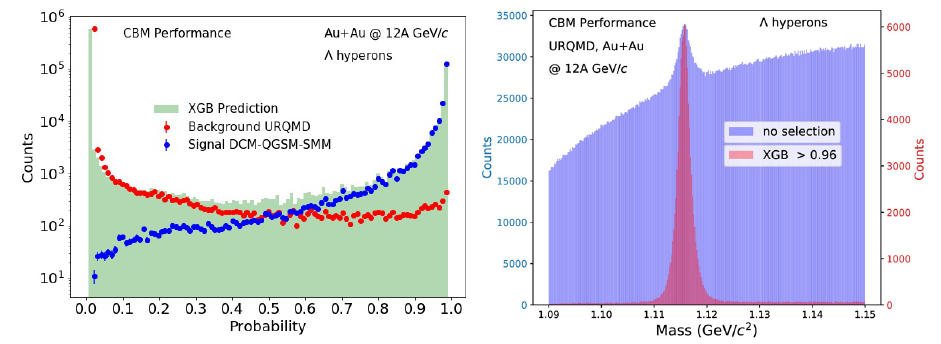
Figure 1. (left) Performance of the XGB algorithm for signal–background separation in the Λ can- didates. The arrow represents the maximum AMS value at which selection was applied. (right) The invariant mass distribution of Λ candidates before (blue) and after XGB selection (red).